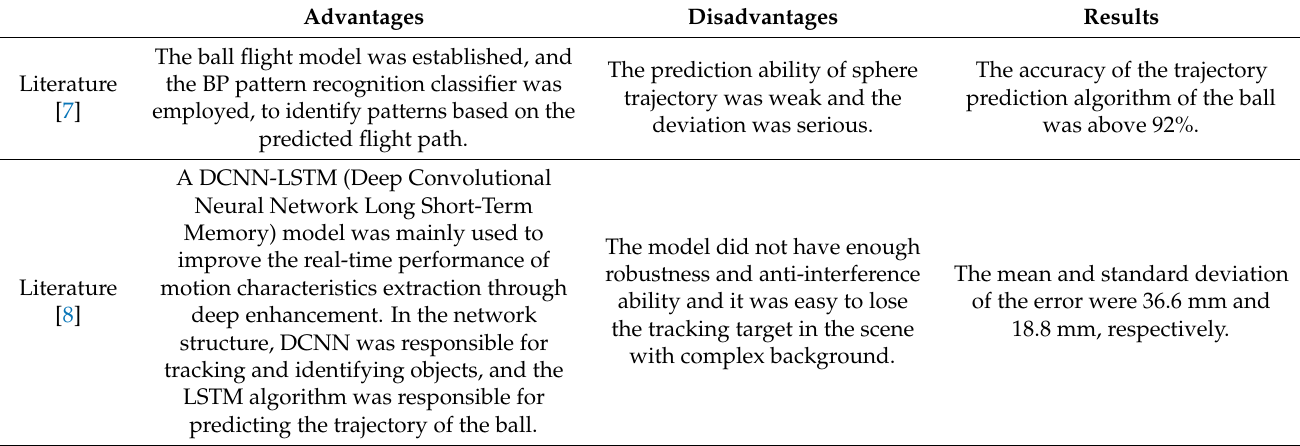
Table 1. Analysis of the previous table tennis trajectory tracking